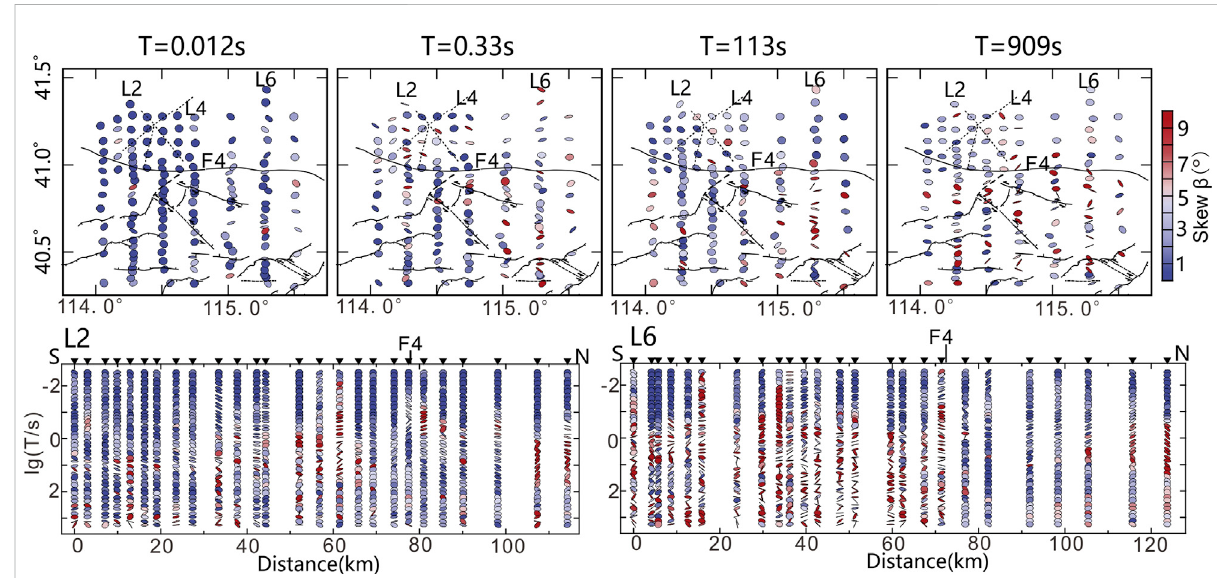
FIGURE 4 Mapview of phase tensor ellipses fi lled with the absolute value of skew angle β for periods 0.012 s, 0.33 s, 113 s, and 909 s (upper). Pro fi ole of phase tensor ellipses fi lled with the absolute value of skew angle β for pro fi les L2 and L6